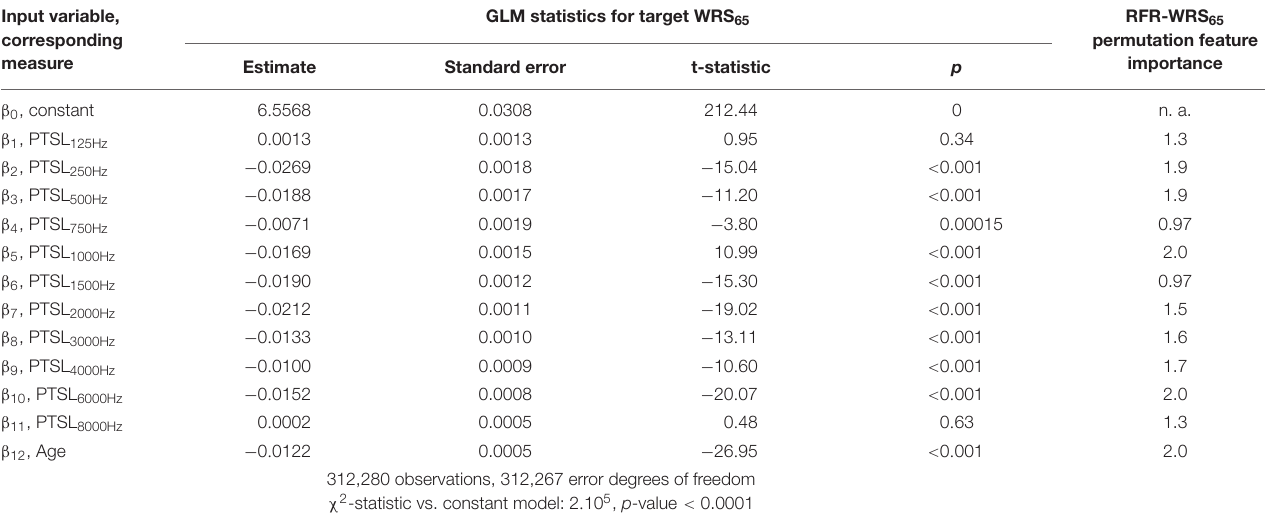
TABLE 1 | GLM parameters for target variable WRS 65 .